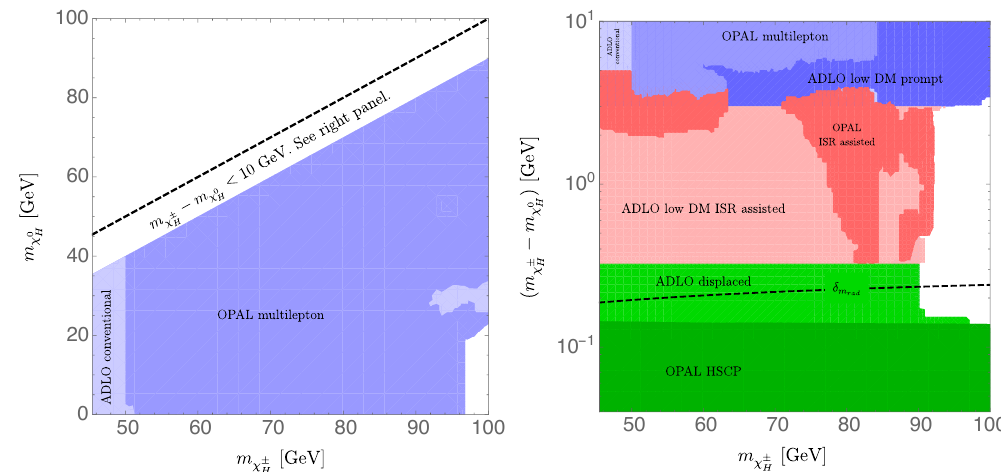
Figure 4 . Limits on the pure higgsino model, set by the searches in table 1, in the uncompressed re- gion (left) and in the compressed region (right). In the uncompressed region the strongest limits are set by the OPAL multilepton search [65] and by ADLO searches for promptly decaying higgsinos [55]. The range m (cid:20) 50 GeV is not covered by the OPAL multilepton search, so we rely exclusively (cid:31) (cid:6) H on the ADLO combination. In the compressed region, the space from 3 GeV (cid:20) (cid:1) m (cid:20) 10 GeV is mainly covered by a combination of the ADLO conventional and ADLO \low DM" prompt searches, as well as by the OPAL multilepton search. The OPAL and ADLO ISR assisted searches [56, 57], set bounds in the regions 320 MeV (cid:20) (cid:1) m (cid:20) 3 GeV and 320 MeV (cid:20) (cid:1) m (cid:20) 5 GeV, respectively. In the region m (cid:20) (cid:1) m (cid:20) 320 MeV, the chargino decays within the detector, and we rely exclusively (cid:25) (cid:6) on the ADLO combination, which contains dedicated searches for kinked tracks and large impact parameters. The region (cid:1) m (cid:20) m is covered by the OPAL HSCP search [71], which applies (cid:25) (cid:6) to particles with a decay length (cid:21) 3 m. The black dashed line indicates the one-loop radiative chargino-neutralino mass